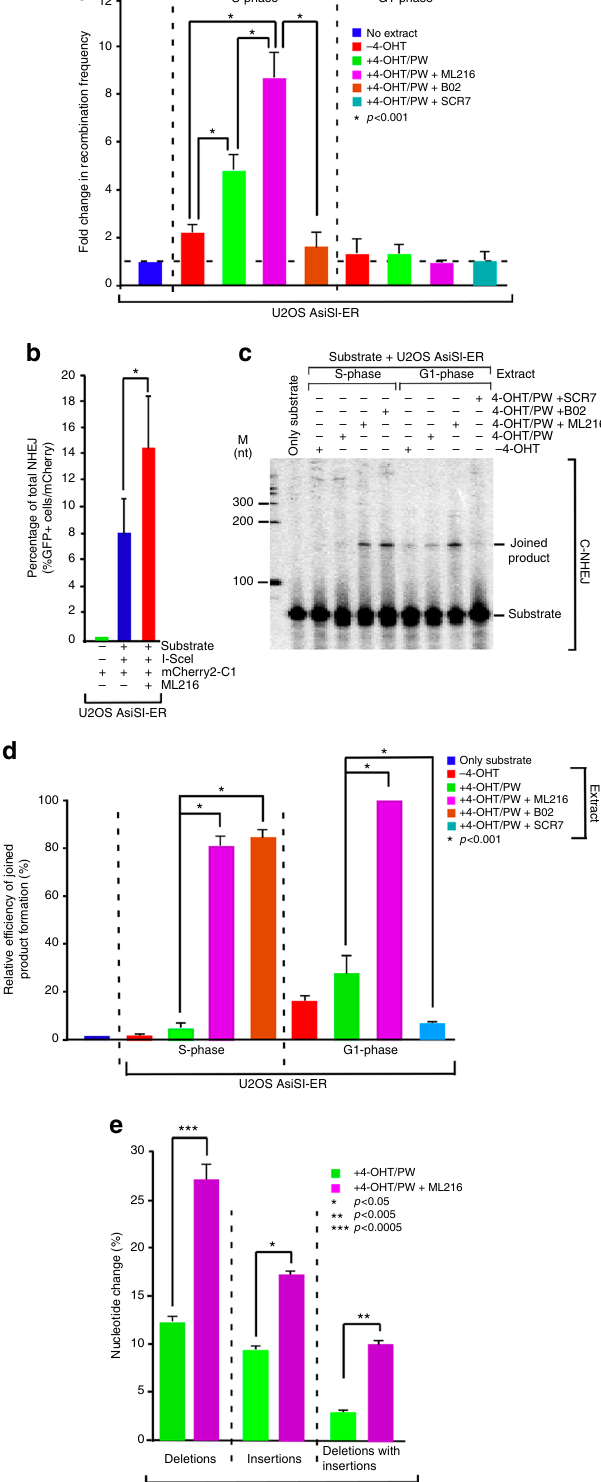
after ML216 treatment in G1-phase is taken as 100% and all other products are calculated relative to the above condition. Data are presented as mean ± standard deviation and the statistical analysis was done by Student ’ s t - test. e Lack of functional BLM enhances nucleotide change at AsiSI